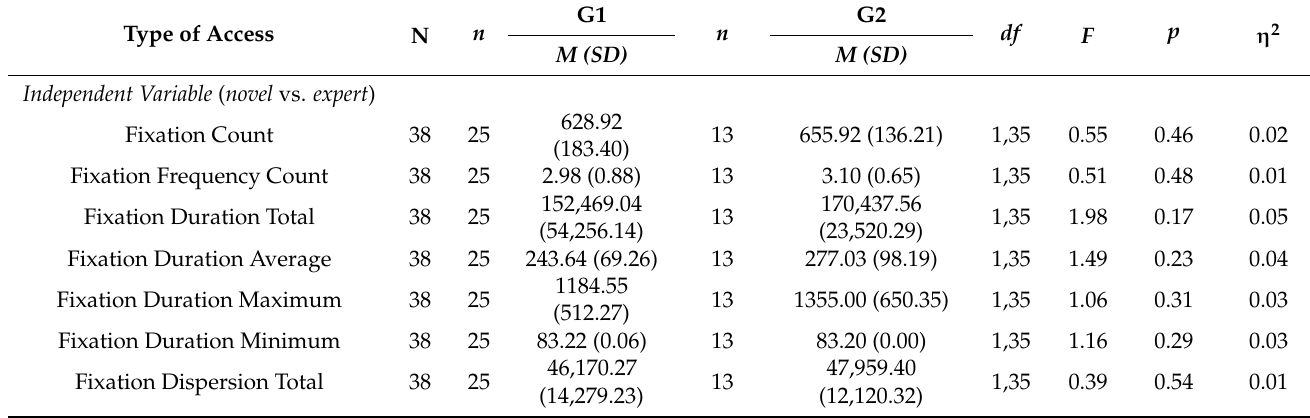
Table A2. One-factor ANCOVA with fixed effects (age over 50 vs. under 50) and covariate (student vs. teacher). Type of